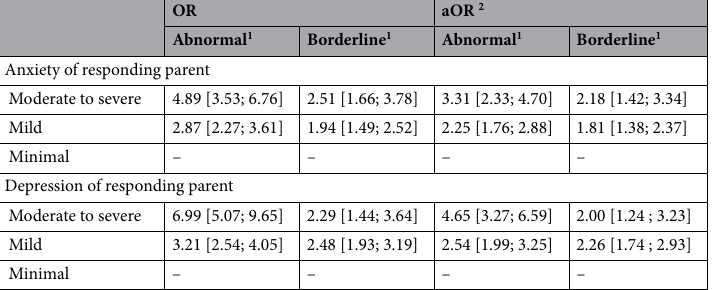
Table 3. Association between parents’ mental health issues and children’s hyperactivity/inattention score: multinomial logistic regressions (n = 3496). 1 Normal is reference group. 2 Results adjusted on child’s emotional symptoms score, child’s sleeping difficulties, child’s sex, sex of responding parent, if the child lived with both parents, parents’ occupational category, household income per month before lockdown and perceived financial situation since lockdown.